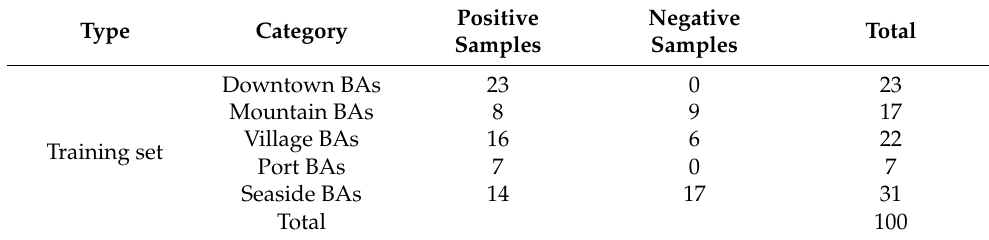
Table 2. Basic information of training sample